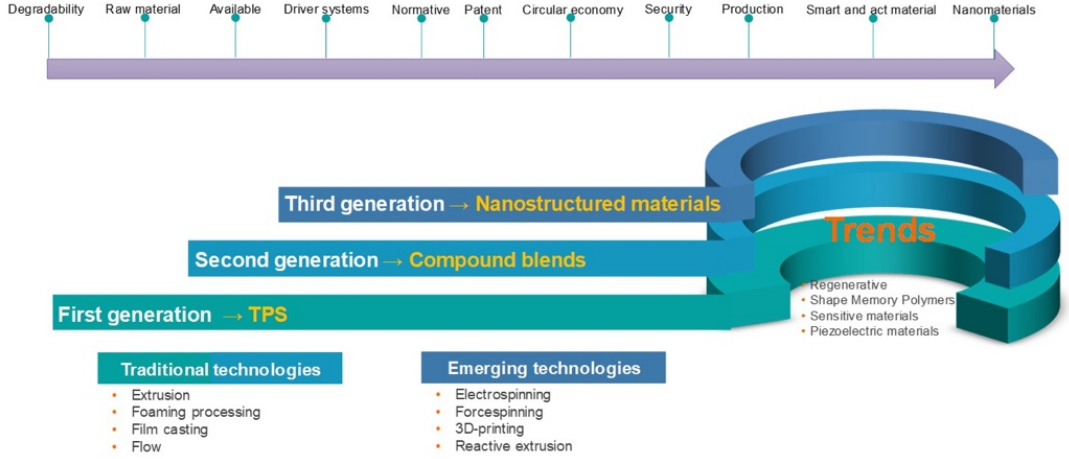
Figure 2. Evolution of starch-based materials.